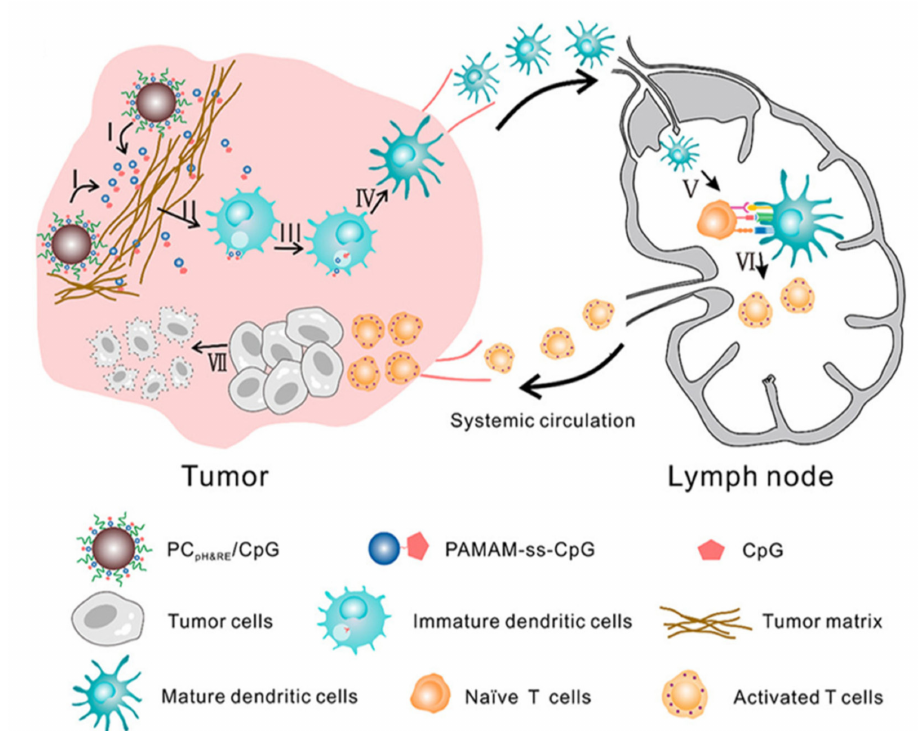
Figure 2. Schematic illustration of PAMAM nanocarrier to deliver TLR 9 agonist for cancer im- munotherapy. I: PAMAM-ss-CpG release from nanocarrier in acidic tumor microenvironment. II: Uptake of PAMAM-ss-CpG by DCs. III: CpG release from PAMAM by reduction of the disulfide bond in intracellular environment. IV: Activation of DCs by CpG, V: Translocation of DCs toward lymph nodes. VI: Naïve T cell activation by matured DCs. VII: Facilitated infiltration into tumor tissues and anti-tumor effect of CD8 + T cell. Reproduced with permission from ref. [35]. 2020 American Chemical